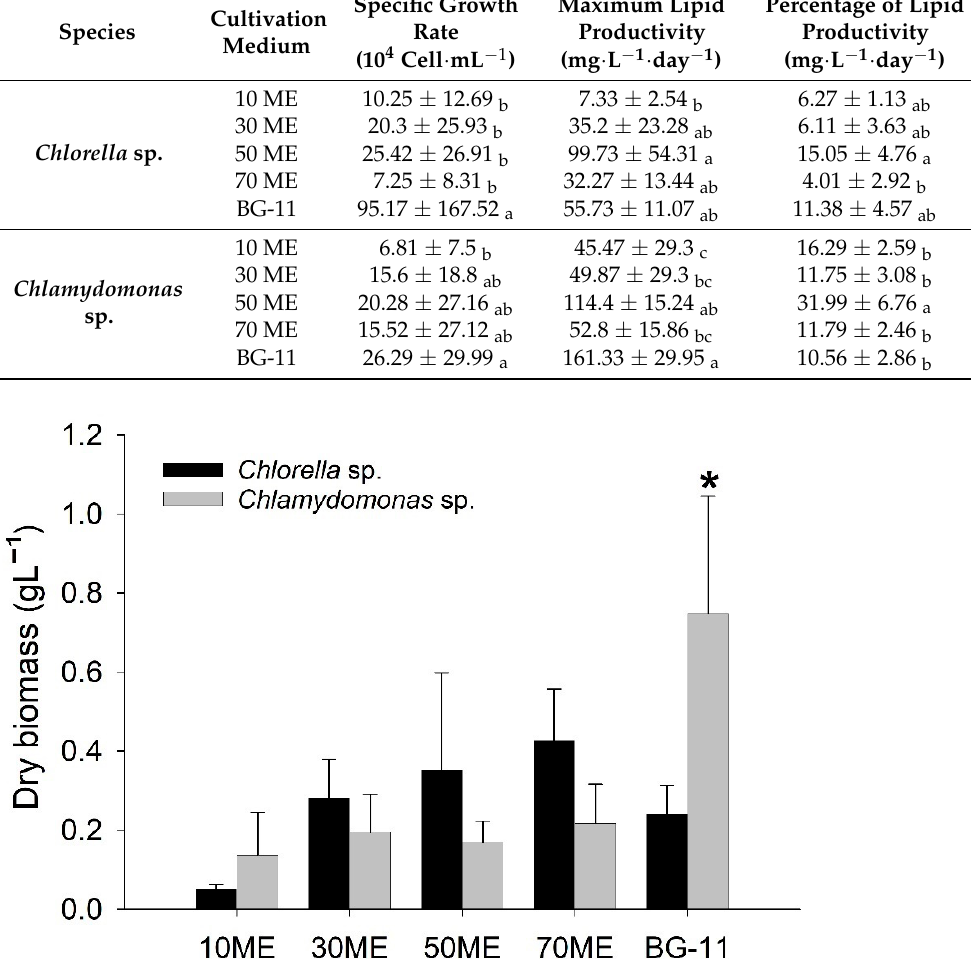
Figure 5. Variation of dry biomass ( a ) Chlorella sp. and ( b ) Chlamydomonas sp. cultivated using the diluted malting effluent and standard mineral media (BG ‐ 11) during 22 days of cultivation time. The bars represent mean biomass and errors refer to standard deviation. The statistics were derived from a one ‐ way ANOVA with post hoc Tukey test. The different letters above the bar signify the significant difference at p < 0.05. Our results revealed that the diluted, non ‐ sterile malting effluent could be a nutrient medium for large ‐ scale algal growth. Although limited studies are available on the growth pattern of freshwater microalgae in malting effluent, available studies revealed that malt ‐ ing effluent is an excellent source of nitrogen and other nutrients and stimulates higher algal biomass production [21,40]. Wastewater contains abundant organic matter and amino acids and promotes the algal growth [41]. Furthermore, wastewater also contains some metal elements useful for the algal growth [42] accumulation of microalgae. Some of the elements, for example, potassium, iron, and zinc ions, promote the growth of algae and lipid accumulation through increasing the specific growth rates and provoking the